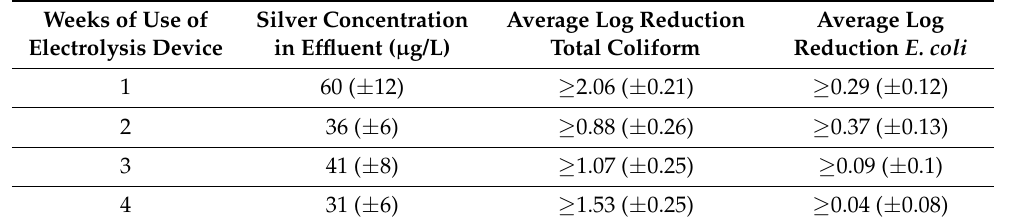
Table 3. Silver concentration and log reduction in total coliform and E. coli bacteria with respect to time measured in effluent water from the intervention over four weeks. Displayed is the average ( ± SEM) silver concentration.